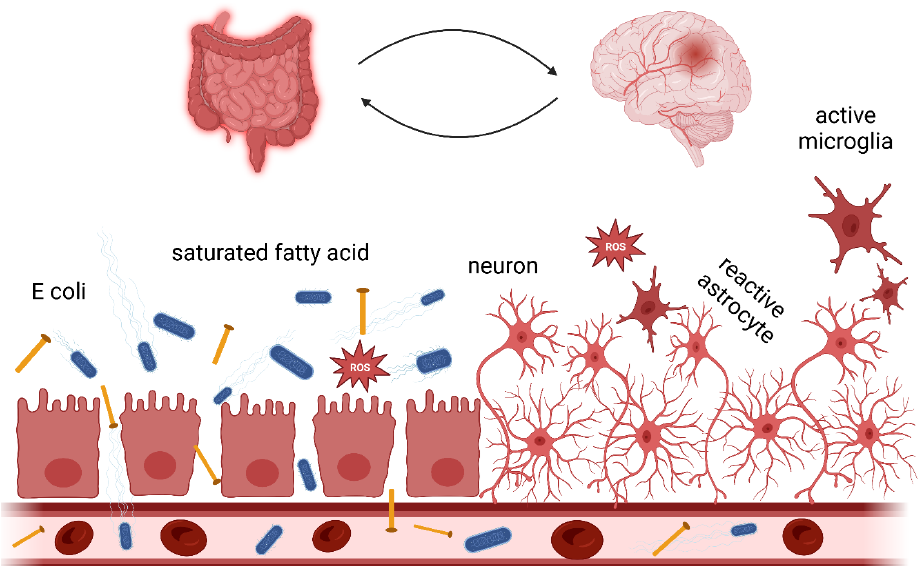
Figure 1. Dietary lipids in the gut-brain axis. Dietary lipids intake can alter gut microbiome balance by increasing the Gram-negative bacteria population [58]. Saturated fatty acid consumption and metabolism affect gut health through reactive oxygen species generation [59]. Chronic gut inflammation can disrupt the intestinal tight junction and consequently lead to a “leaky gut”. Neurotoxins can penetrate the intestinal epithelium and, through the bloodstream, reach the BBB. A compromised BBB facilitates neurotoxins entering the brain and inducing inflammation [53,54]. Active microglia cells and reactive astrocytes can harm neuron cells.